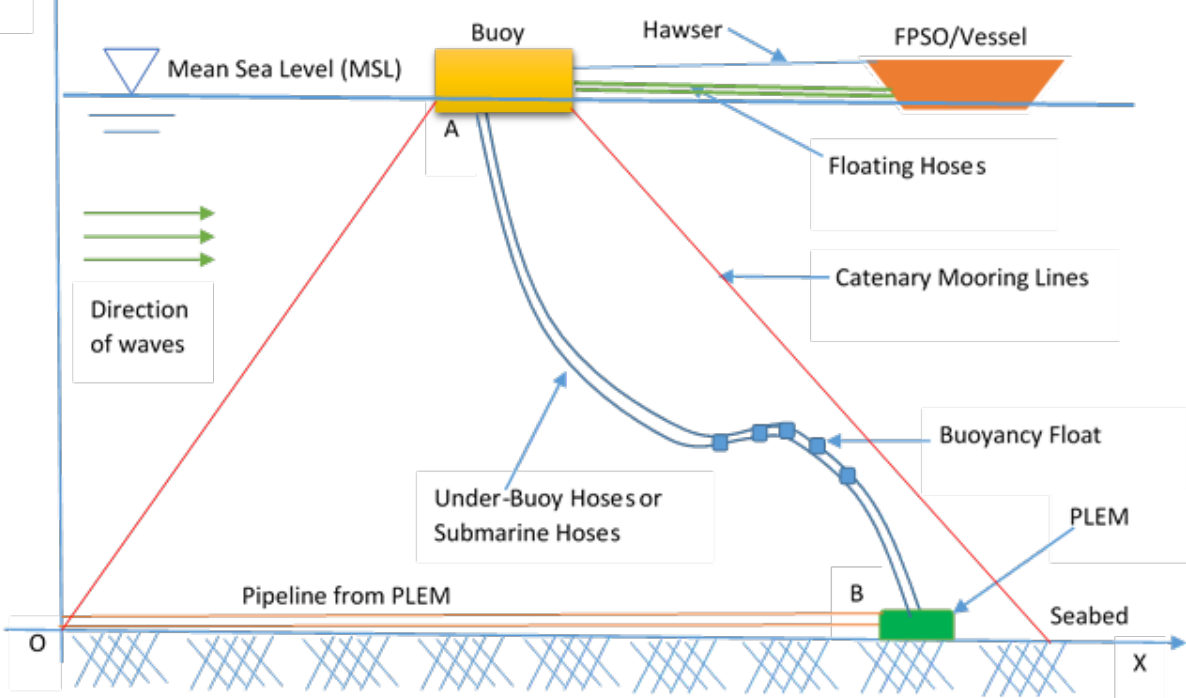
Figure 1. CALM buoy in Lazy-S configuration depicting offloading and loading operation .